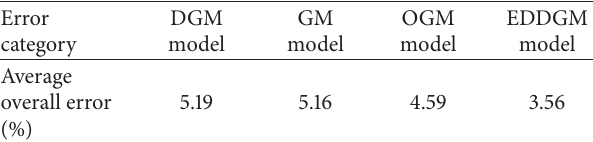
Table 3: Average relative fitting errors of four models.